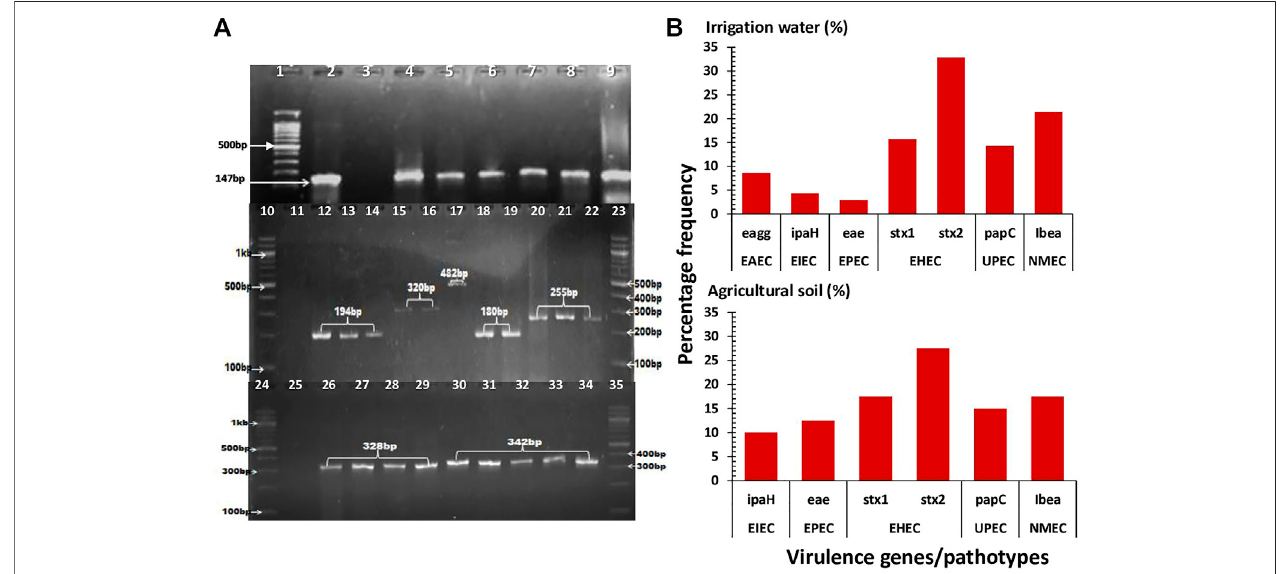
FIGURE 2 | The con fi rmation, pathotype characterization and prevalence of the pathogenic strains of E. coli in irrigation water and agricultural soil samples. (A) : A representative gel imageshowing the PCRampli fi cation ofthe housekeeping uid Agene (lane 4 – 9) and VGs including eagg (lane12 – 14), ipa H(lane 15and 16), eae (lane 17), stx1 (lane 18 and 19), stx2 (lane 20 – 22), pap C (lane 26 – 29) and ibe A (lane 30 – 34). Lane 1, 10, 23, 24 and 35 represents 100bp DNA ladder, lane 2 represents positivecontrol ( E.coli ATCC 25922), lane 3, 11and 25representsnegativecontrol. (B) : The prevalence ofthe detected VGsencoding for thevarious